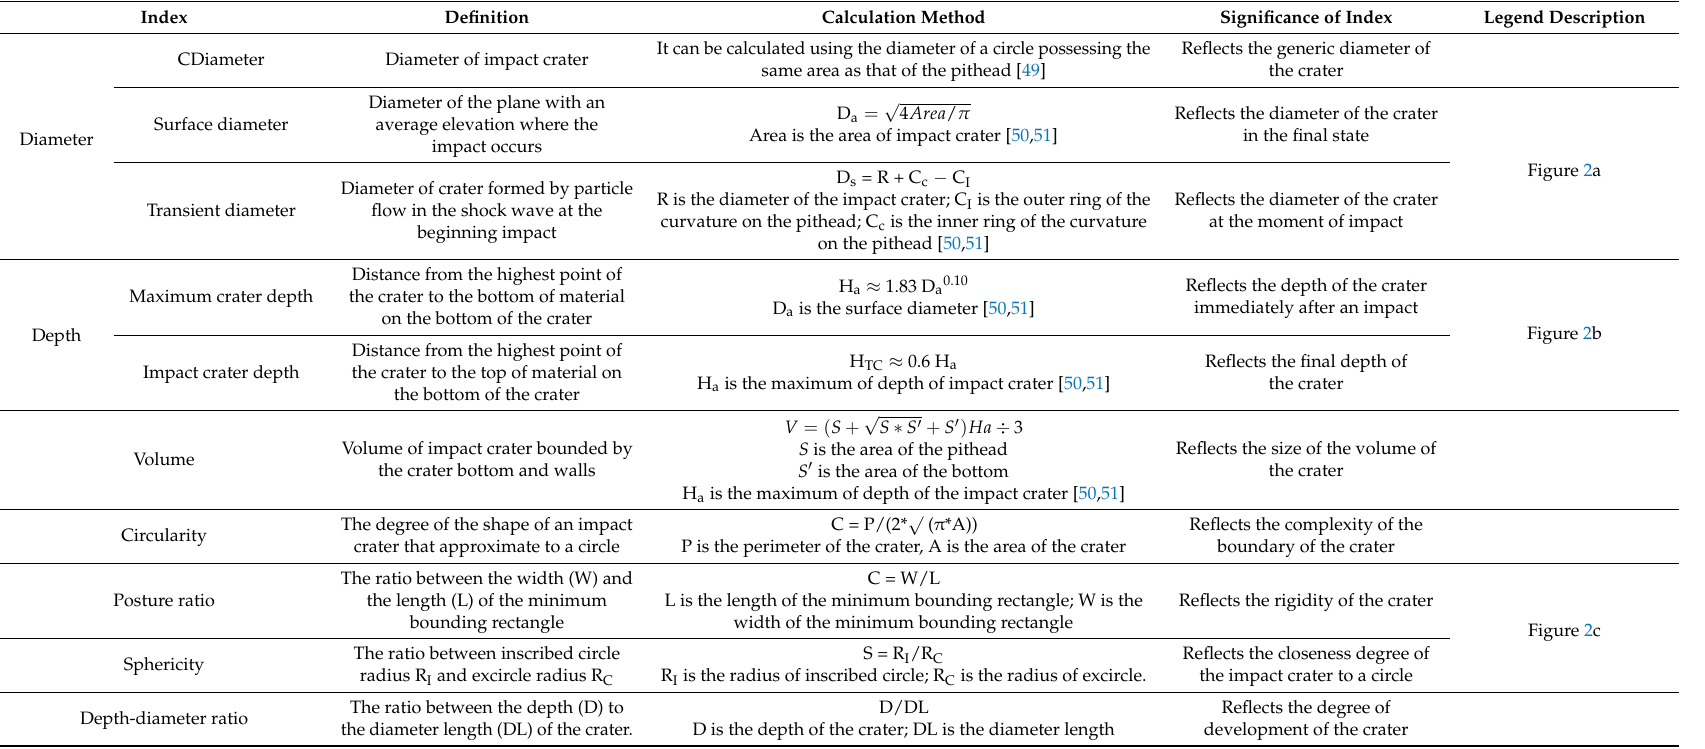
Table 1. Indices for description of the basic